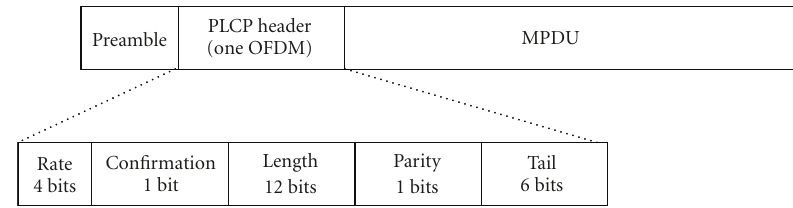
Figure 3: Fig. 3. PLCP header structure with confirmation subfield in Data packet.